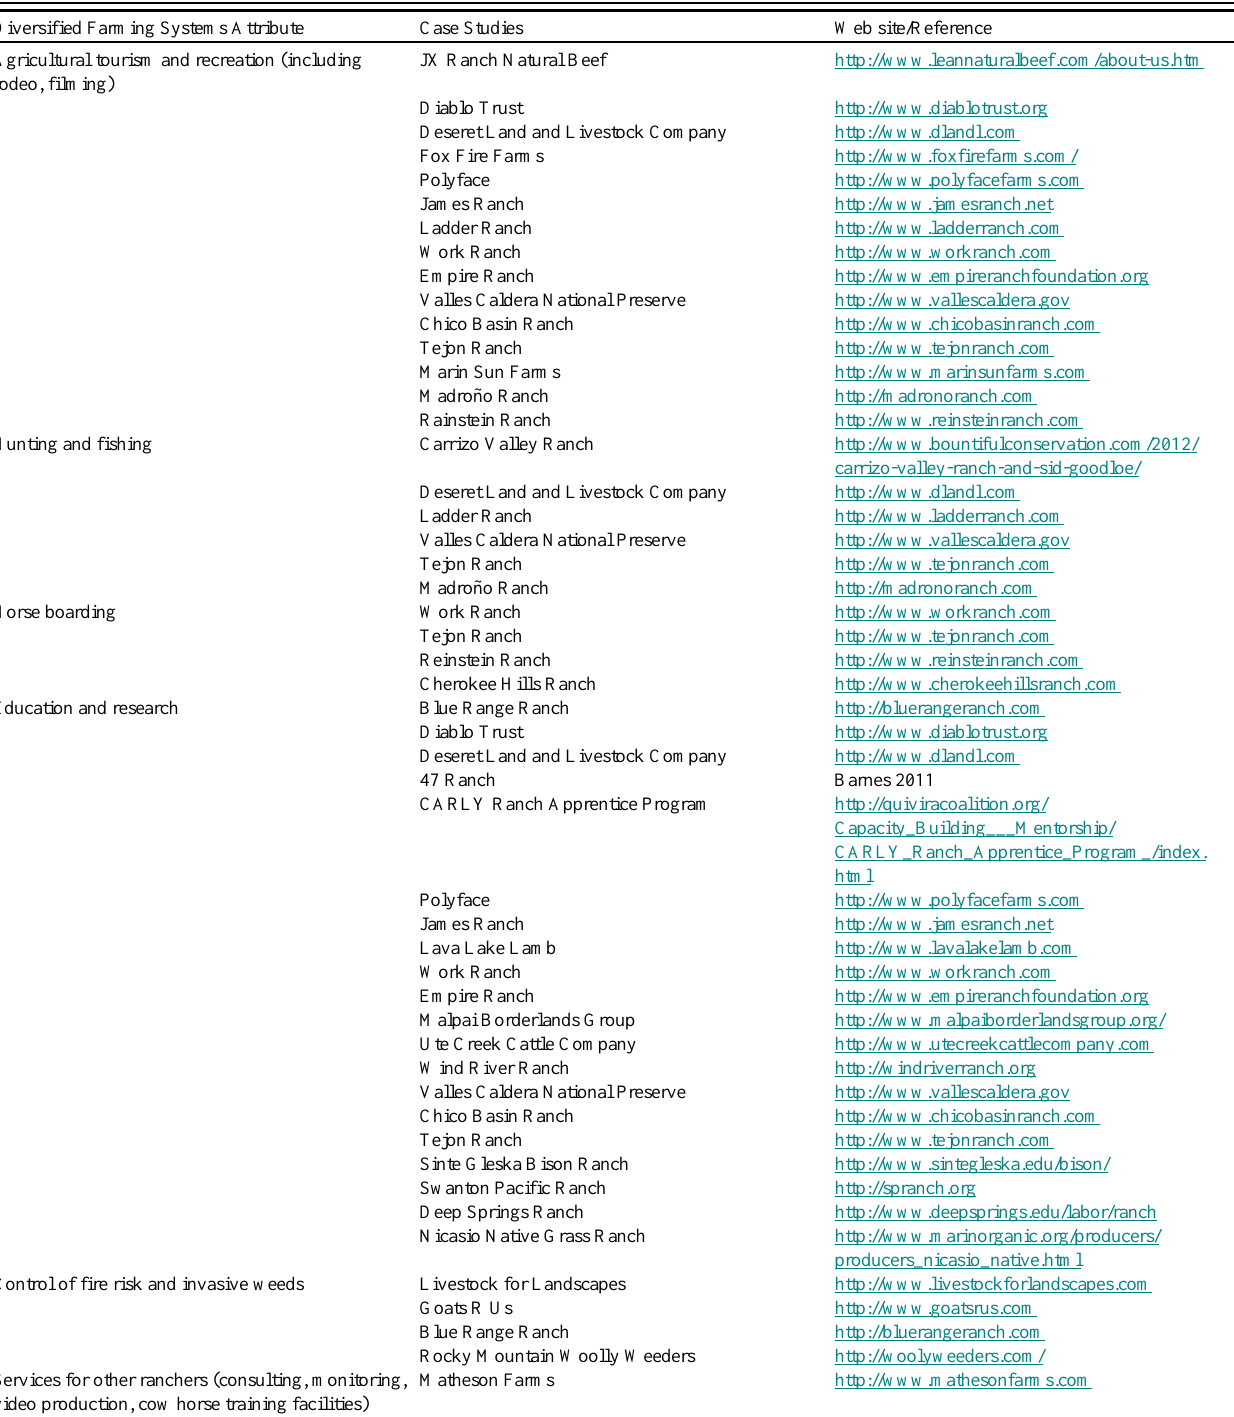
Table 5 . Diversification of